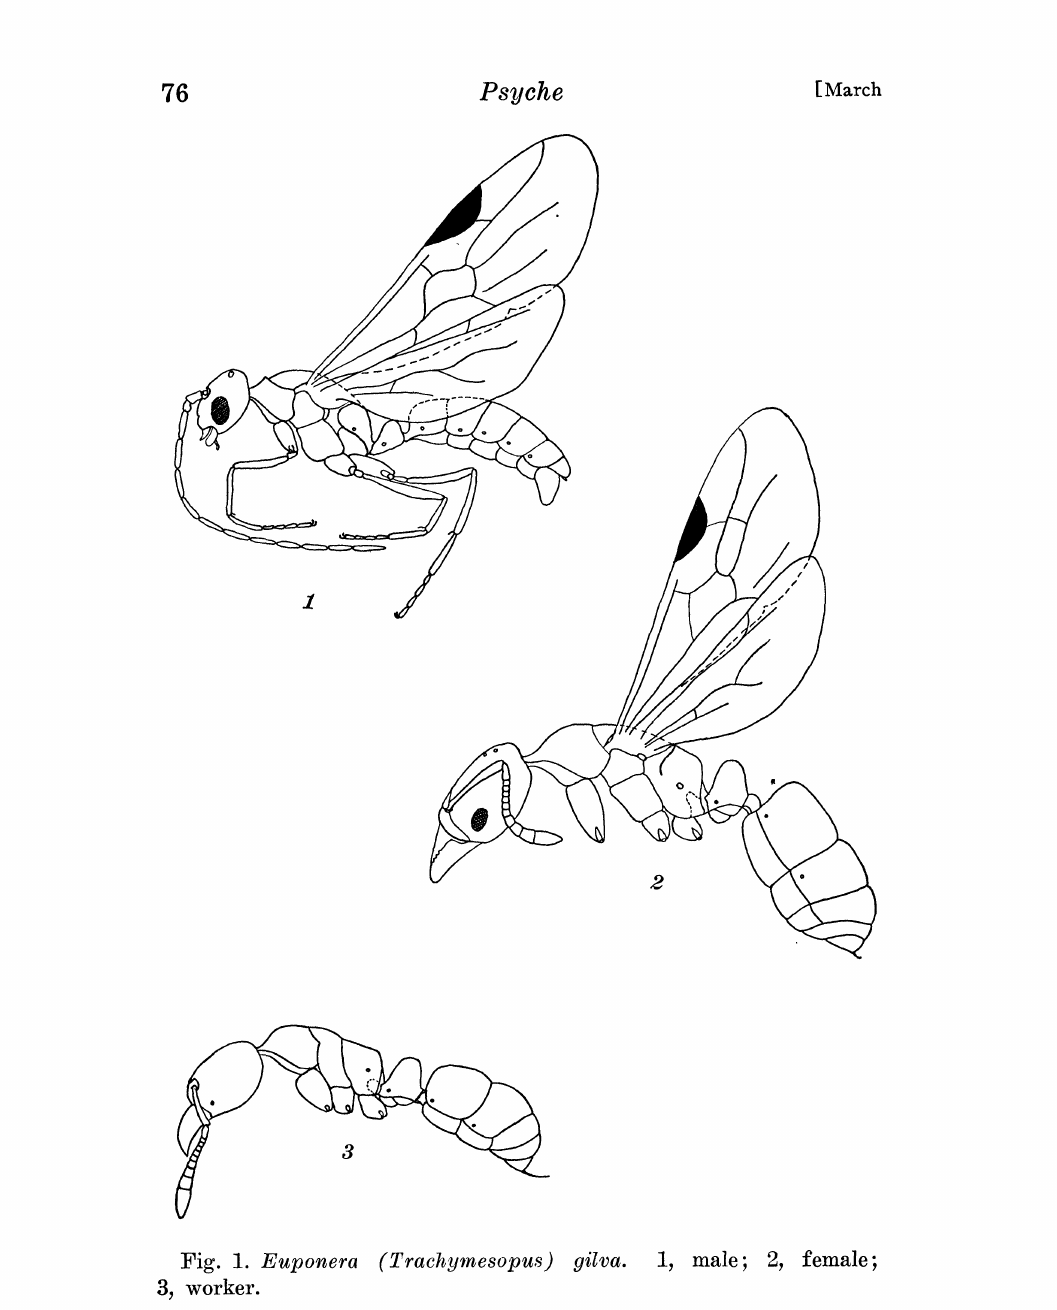
Fig. 1. Euponera (Trachymesopus) gilva. 1, male 2, female 3,